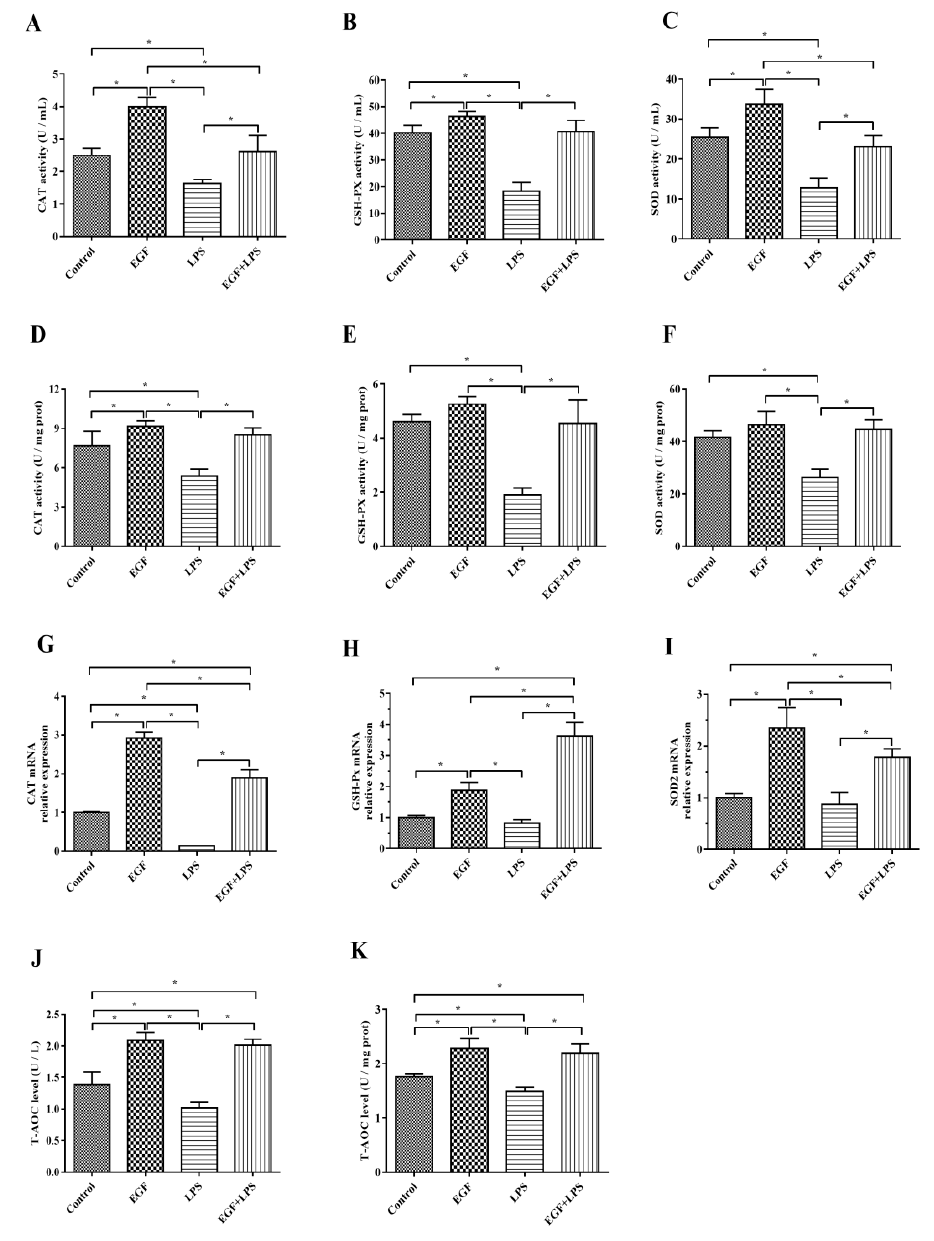
Figure 3. Effects of EGF on antioxidation capacity of IPEC-J2 cells challenged by LPS. ( A ) CAT activity in cell supernatant; ( B ) GSH-PX activity in cell supernatant; ( C ) SOD activity in cell supernatant; ( D ) CAT activity in cells; ( E ) GSH-PX activity in cells; ( F ) SOD activity in cells; ( G ) CAT gene expression; ( H ) GSH-PX gene expression; ( I ) SOD2 gene expression; ( J ) T-AOC levels in cell supernatant; ( K ) T-AOC levels in cells. Data are presented as mean ± SD, n = 3, * p < 0.05.